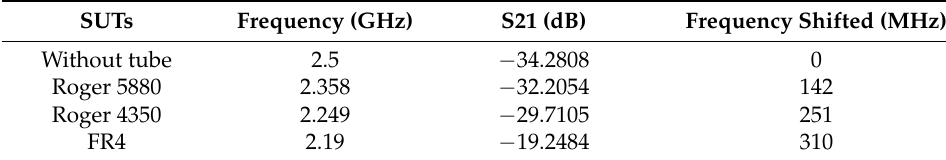
Table 4. Simulation datasets of curve-feed CSRR design with several SUTs.